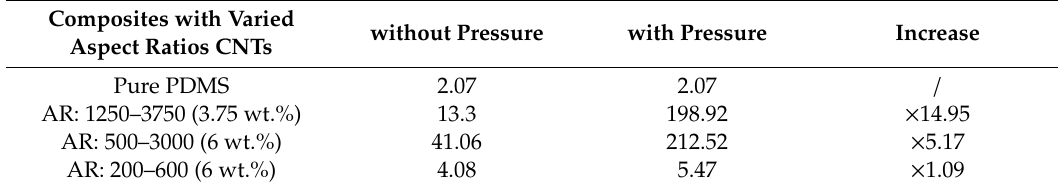
Figure 5. Mass fraction related relative permittivity of the composites based on CNTs filler with di ff erent aspect ratios with and without pressure, ( a ) 1250–3750, ( b ) 500–3000, ( c ) 200–600. Table 3. The relative permittivities of the CNTs / PDMS composites with di ff erent aspect ratios CNTs fillers with and without pressure.